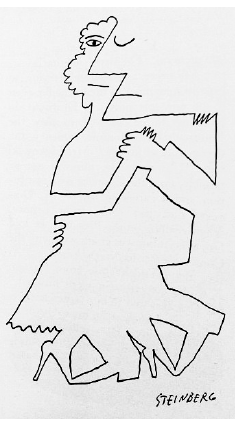
Figure 11. S. Steinberg , Drawing from The Passport , 1954.